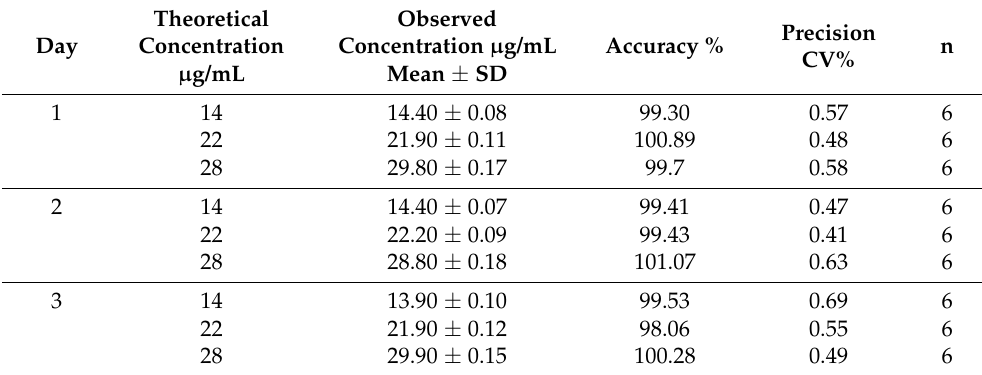
Table 5. Results of intra-day analyses of 3 quality control samples of various concentrations of propofol solutions in methanol.